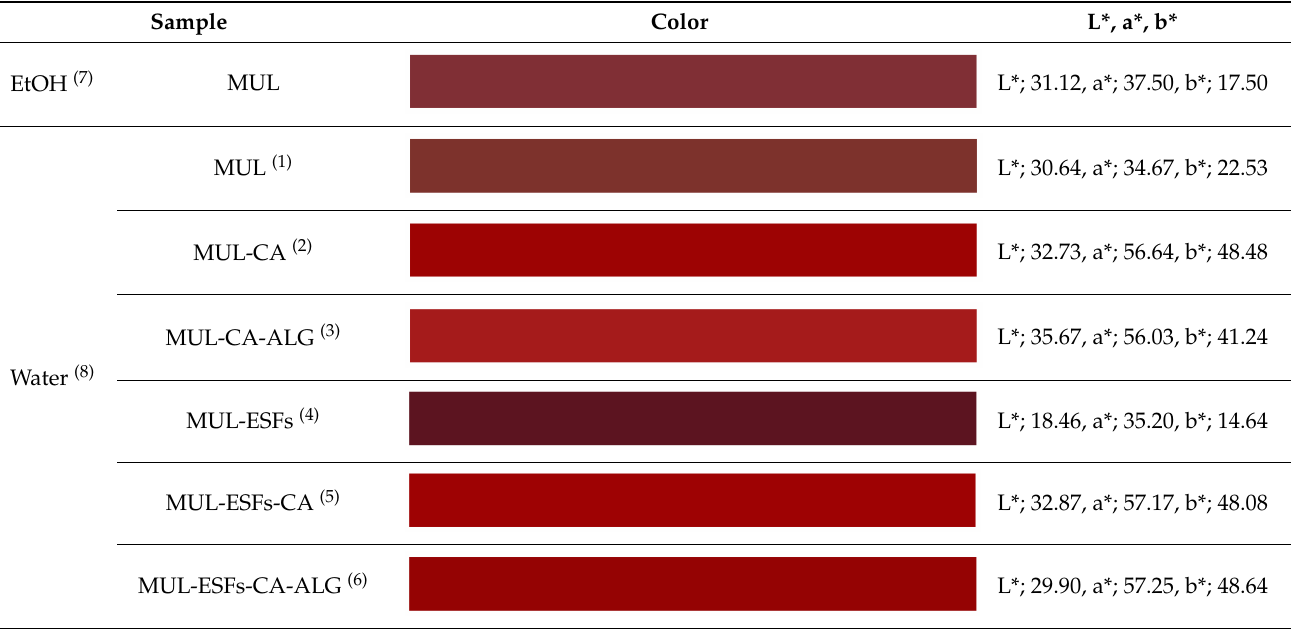
Figure 2. The content of ATCs in MUL extract (mg/g). MUL-CA; MUL treated with 0.5 M citric acid, MUL-CA-ALG; MUL treated with 0.5 M citric acid and 0.3% sodium alginate, MUL-ESFs; only solid formulations of MUL-extrudate, MUL-ESFs-CA; solid formulations of the extrudate of MUL treated with 0.5 M citric acid, MUL-ESFs-CA-ALG; solid formulations of the extrudate of MUL treated with 0.5 M citric acid and 0.3% sodium alginate 0.3%, MUL (EtOH); the extraction of MUL with 80% ethanol, MUL (water); the extraction of MUL with water. Table 2. Color difference meter measuring the color of MUL extracts (25,000